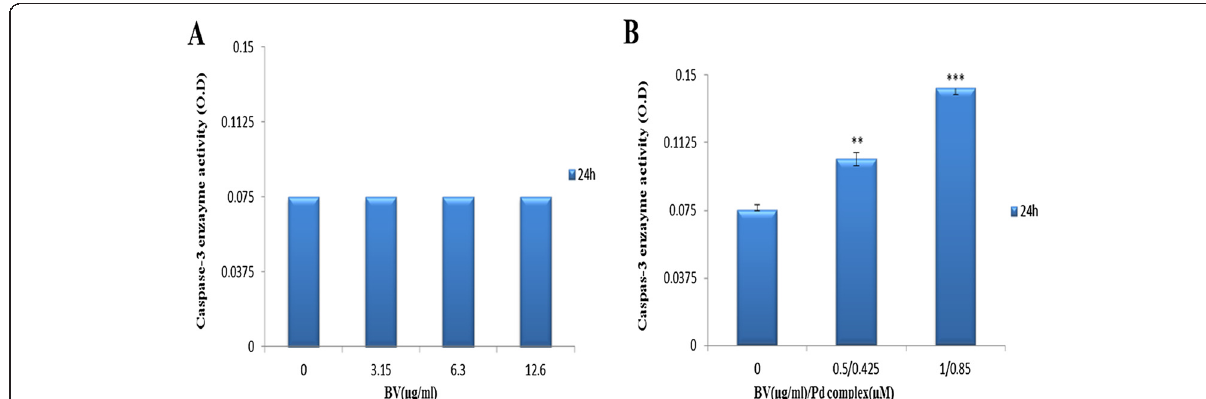
Figure 4 Results of caspase-3 enzyme activity assay. Cells treated (A) with BV and (B) with BV/Pd (II) complex. The optical density was measured at 405 nm. The OD values were not altered by increasing BV, while the OD values rose following a dose increase from 1/2Cc 50 BV/Pd (II) complex [0.5 μ g/mL BV/0.425 μ M Pd (II) complex] to Cc 50 BV/Pd (II) complex [1 μ g/mL BV/0.85 μ M Pd (II) complex] compared to the control. Data represent mean ± SEM of three different experiments. n = 3; *** p > 0.001 significantly different from the